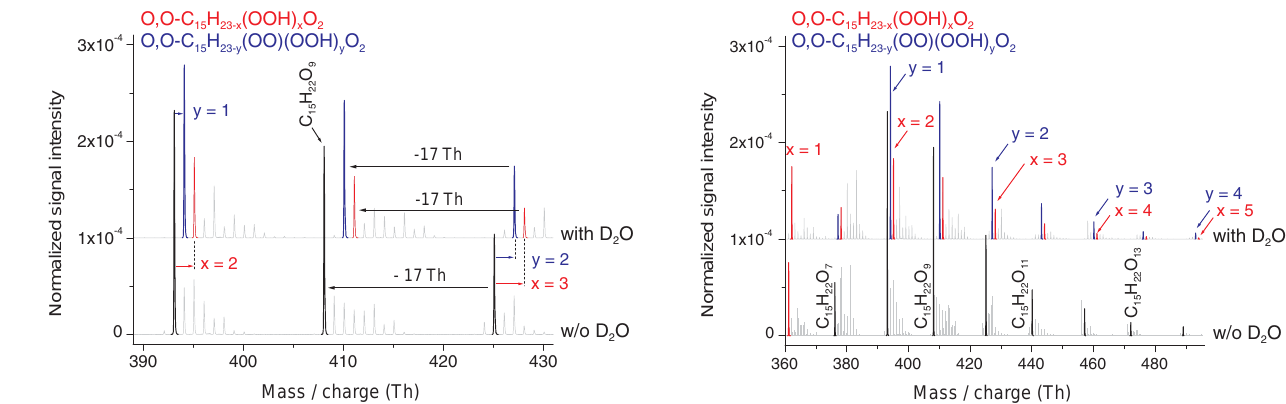
both ionization techniques is not necessarily identical